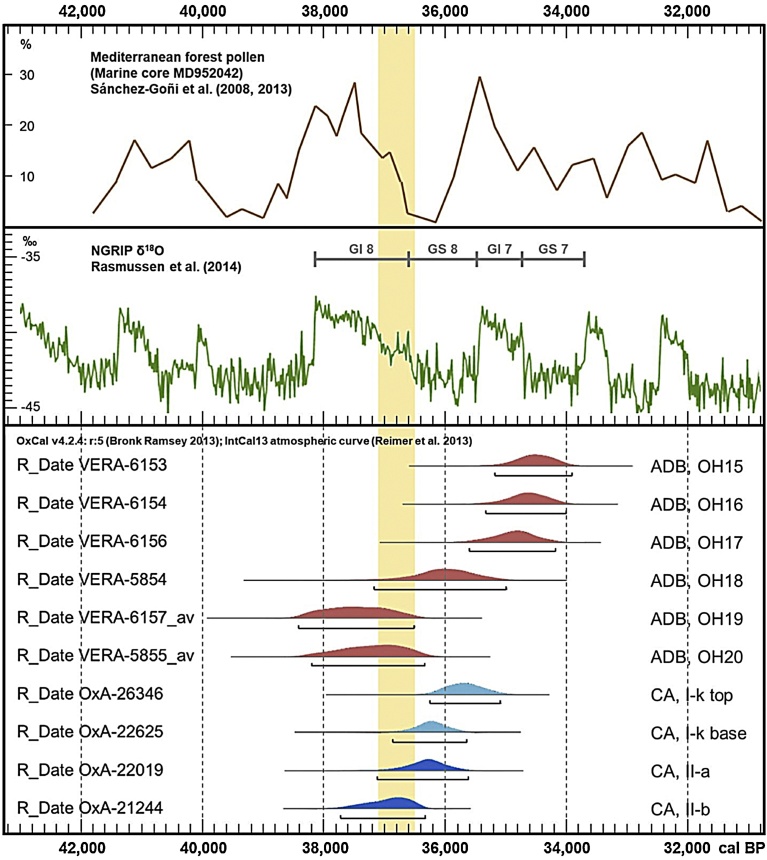
Chronology of the Middle-to-Upper Paleolithic transition in the Mula basin sites. Plot of calibrated radiocarbon dates (95.4% probability intervals) for the Aurignacian of La Boja and for the Mousterian (layer I-k) and immediately underlying alluvium (layers II-a and II-b) of Cueva Antón. The vertical yellow band denotes the interval during which the transition took place: between 36.5 ka, the youngest possible age of La Boja’s Aurignacian in OH19-20, and 37.1 ka, the oldest possible age of the Cueva Antón Mousterian as provided by the layer II-a terminus post quem. The comparison with the global proxies (Rasmussen et al., 2014, Sánchez-Goñi et al., 2008, Sánchez-Goñi et al., 2013) shows that, in the Mula basin, the transition coincides with the end of a long and mild temperate phase, Greenland Interstadial 8.